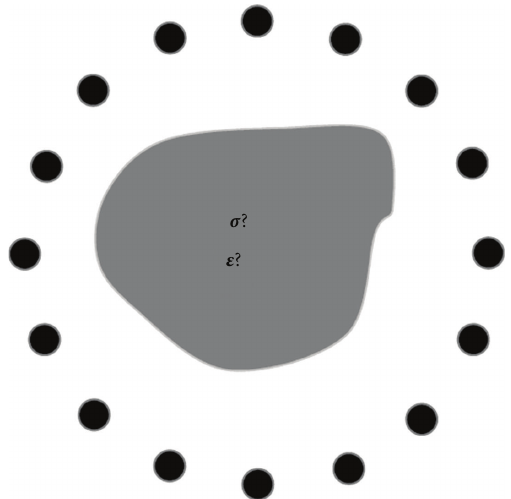
Figure 1: The microwave inverse scattering problem. The object with unknown dielectric properties is surrounded by an array of antenna. The objective is to determine the unknown dielectric properties based on the measured return signals from the antennas